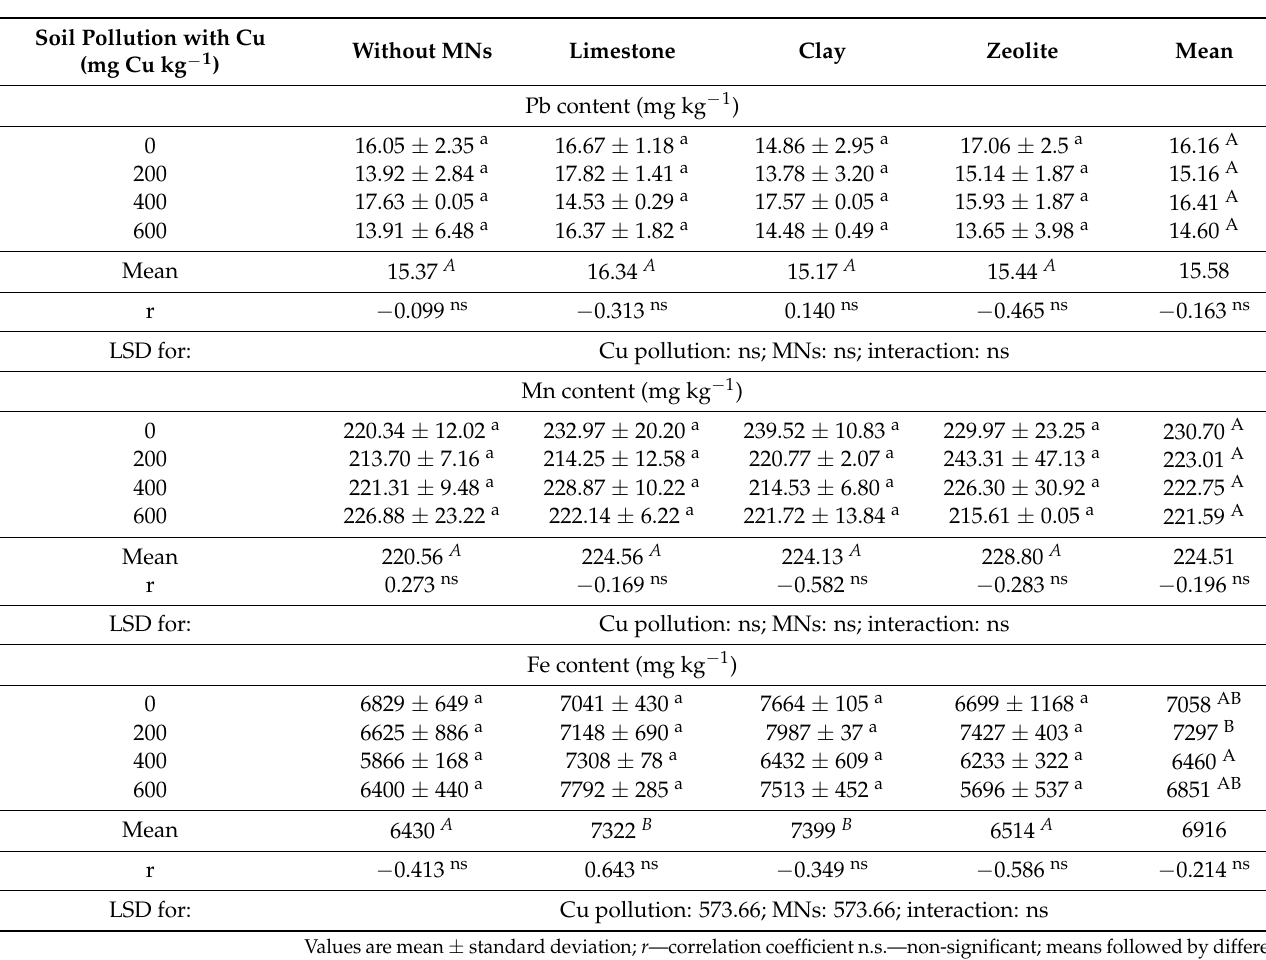
Table 5. Pb, Mn, and Fe content in the soil after black mustard ( Brassica nigra L. Koch) harvest.